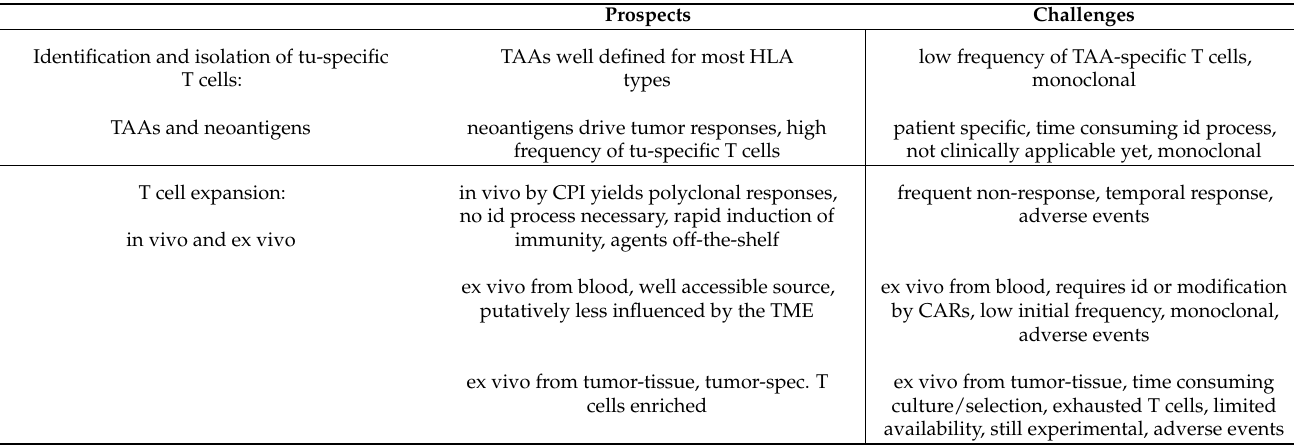
Table 2. This table summarizes the prospects and challenges of T cell-based